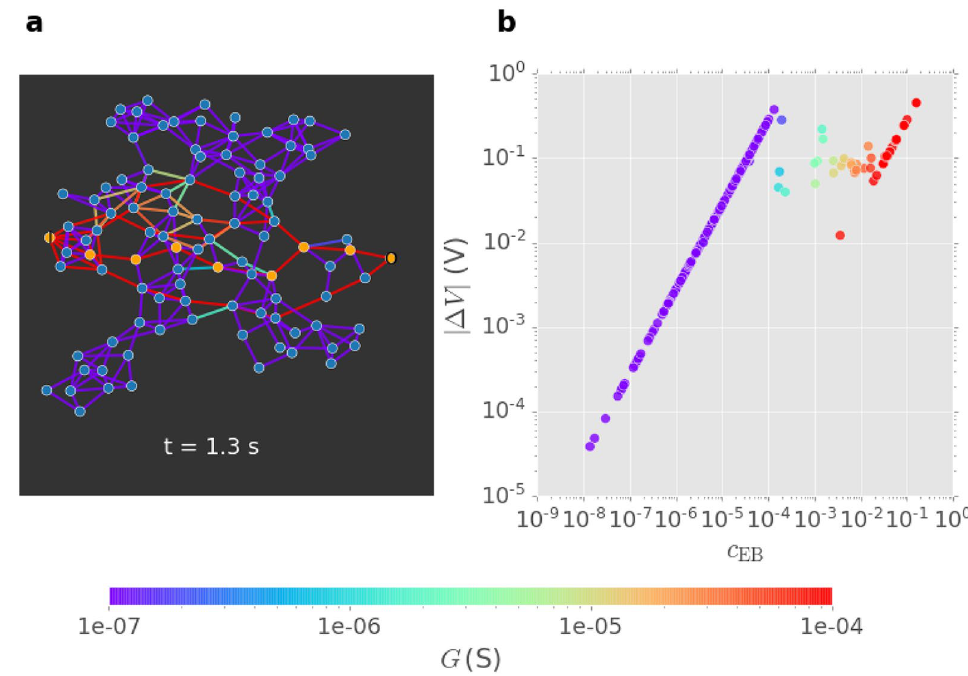
Figure 1. Simulation of a neuromorphic NWN with 100-nanowire nodes and 261-junction edges. ( a ) Snapshot of network graph at t = 1.3 s, showing the first current path (between orange nodes, established earlier at t = 1.218 s) and edge (junction) conductance (colourbar). ( b ) Magnitude of voltage difference | (cid:31) V